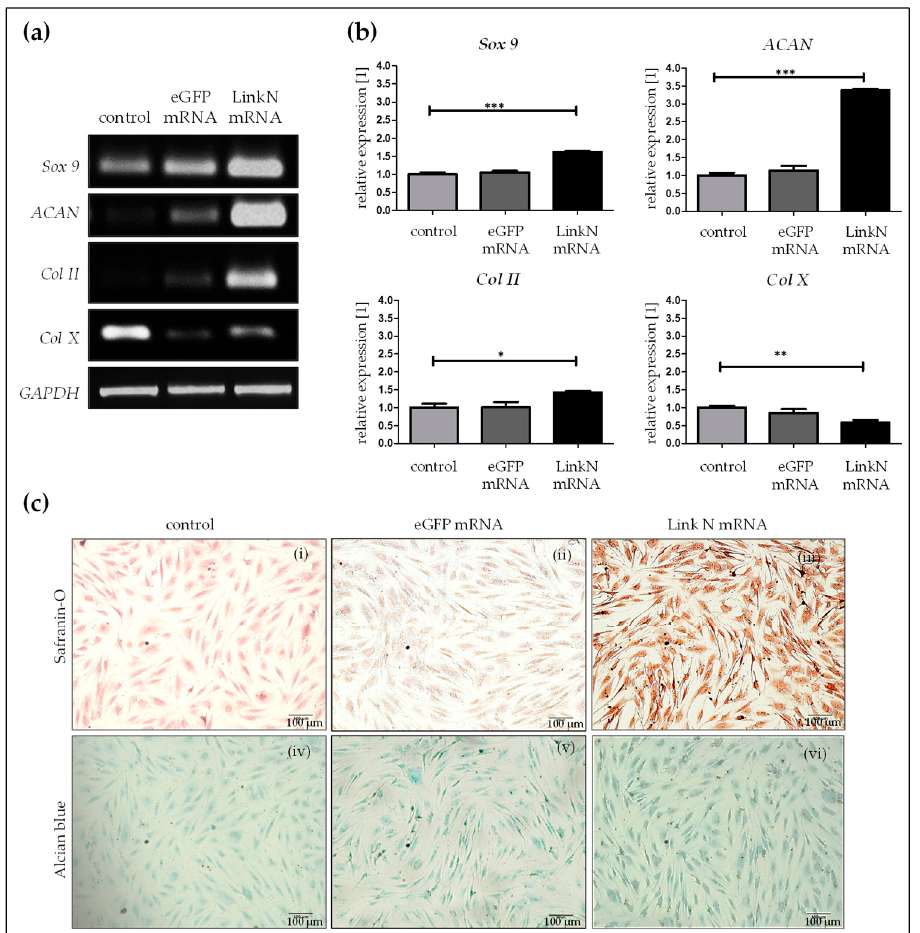
Figure 4. Influence of Link N mRNA delivery into primary chondrocytes on aggrecan ( ACAN ), Sox 9 , collagen type II ( Col II ) and type X ( Col X ) gene expression, and production of collagen and proteoglycan matrix. Primary human chondrocytes (1 × 10 5 ) were transfected with 1 µ g Link N mRNA, and the influence on the expression of chondrocyte anabolic markers was investigated. ( a ) Representative gel images evaluating changes in ACAN , Sox 9 , Col II , and Col X gene expression, 24 h after Link N mRNA transfection. ( b ) Gene expression examined 24 h after Link N mRNA transfection, using semi-quantitative RT-PCR. Cells treated with Lipofectamine 2000 and eGFP